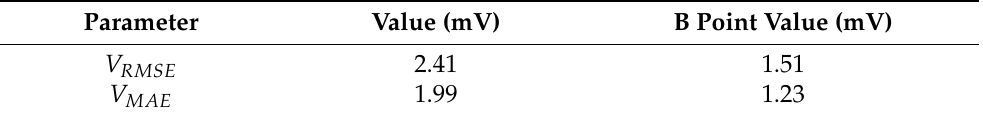
Figure 16. Samples for studying the behavior. Comparison between internal and external voltage measurements. Table 4. RMSE and MAE of the battery voltage with external vs. internal